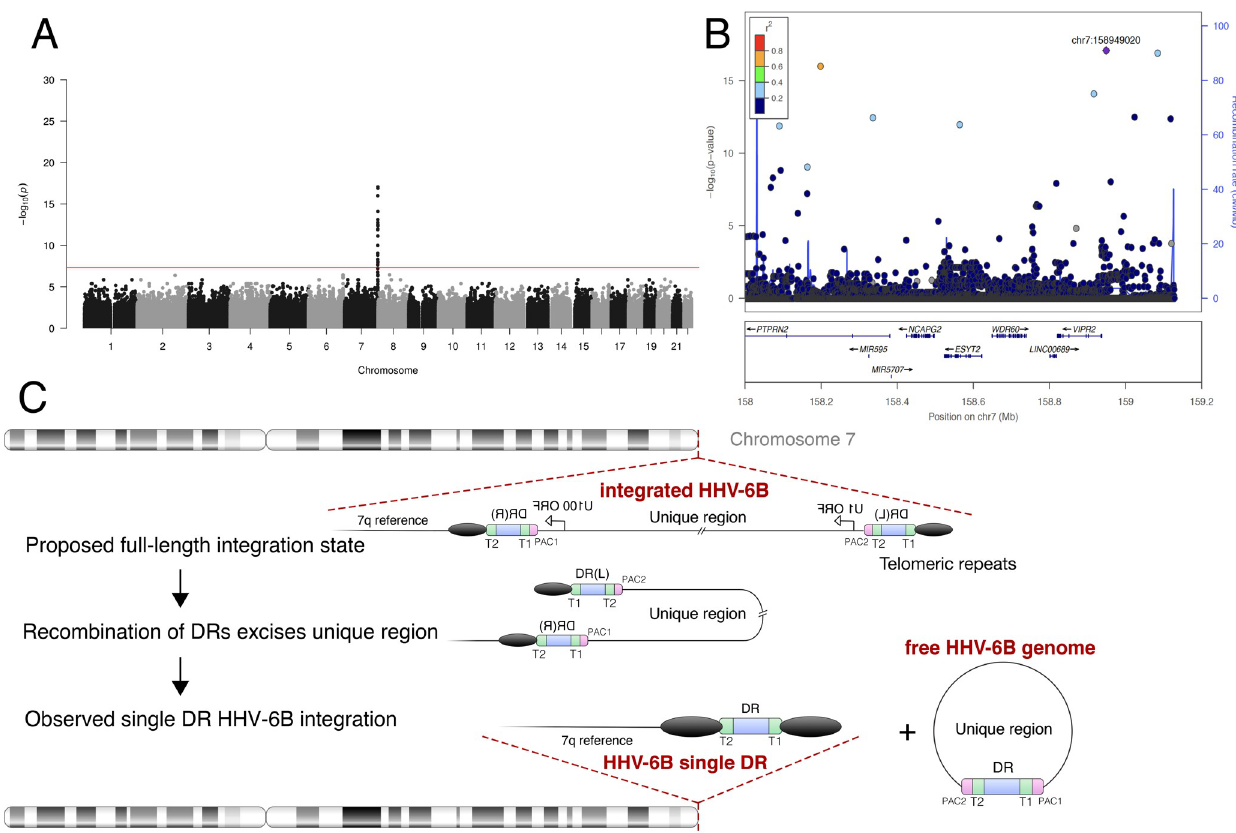
Fig 6. Recombination and excision of HHV-6B from chromosome 7q. A) Manhattan plot from GWAS of subjects bearing HHV-6B solo-DR integration (N = 9). The − log10 P value (Fisher’s exact test) given for each variant is plotted according to the variant’s physical position on the chromosome. B) Regional association plot of the 7q region. The − log10 P value (Fisher’s exact test) for association in the GWAS of integrated HHV-6A are shown. The purple diamond symbol represents the lead variant in the region of the association. Proxies are indicated with colors determined from their pairwise r 2 from the high-depth BBJ WGS data (red, r 2 > 0.8; orange, r 2 = 0.6 − 0.8; green, r 2 = 0.4 − 0.6; blue, r 2 = 0.2 − 0.4; dark blue, r 2 < 0.2 or no information available). C) Model of HHV-6 recombination and excision resulting in the observed integrated solo-DR. Schematic of the proposed germline recombination event (after [34]) leading to excision of the majority of integrated HHV-6B sequence resulting in the integrated solo-DR form.